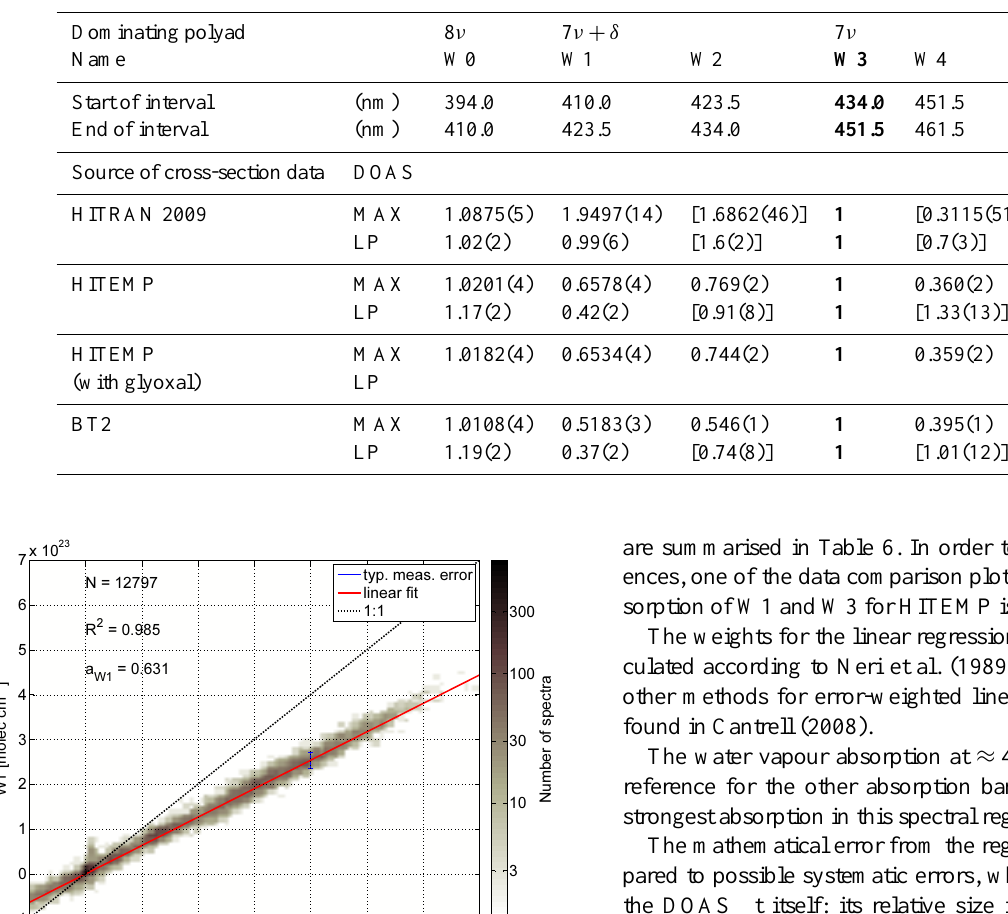
Table 5. Measured relative line strengths for the different cross-sections with respect to the absorption at W3 (see Fig. 1 and Table 3), which is the reference column in bold face. Errors obtained from the linear regression are shown for the last digits in brackets. The relative DOAS fit errors are listed in Table 6. Results with typical DOAS fit errors of more than 25% of the measured values were put in square brackets. MAX-DOAS values are corrected by the results of radiative transfer modelling listed in Table 4.